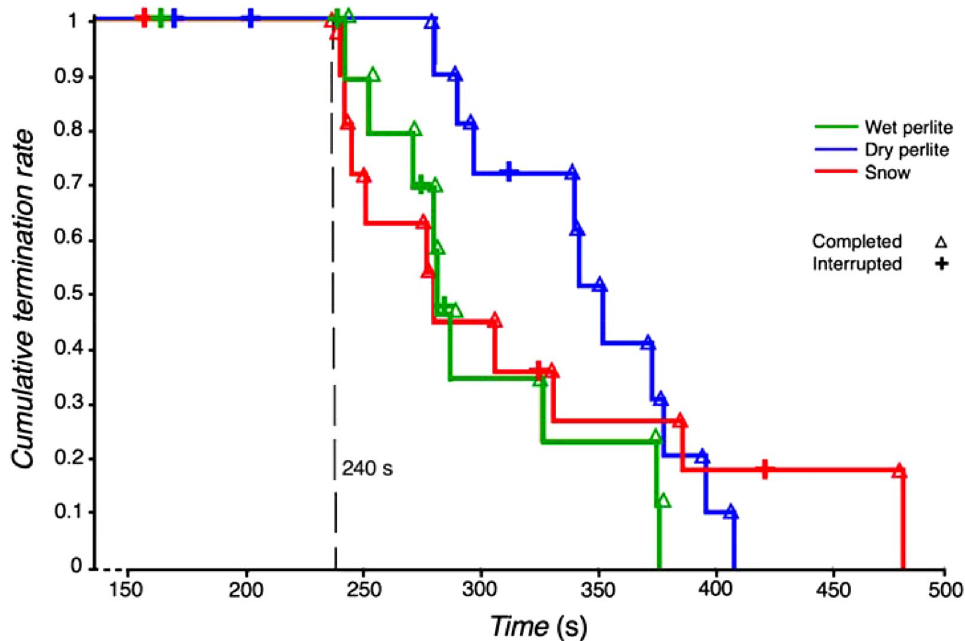
Figure 2. Time to breathing experiment termination for the three different phases: snow (S), dry perlite (PD) and wet perlite (PW). The term “completed” means that the subject terminated the experiment upon his own request, or the experiment was terminated by the supervising physician based on the clinical assessment of the subject. The term “interrupted” means that the experiment was terminated due to accidental disconnection, or detection of N 2 O in the breathing circuit.